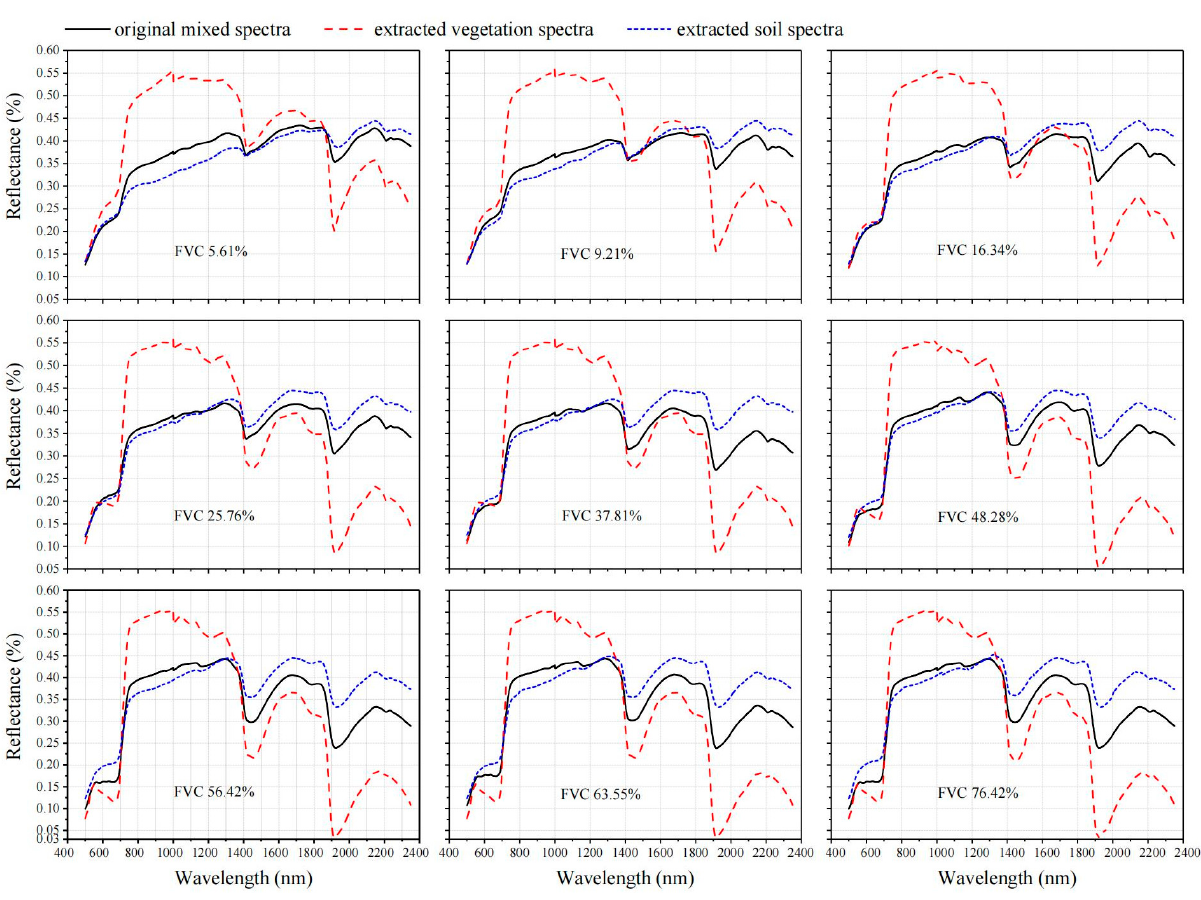
Figure 6. NMF-extracted spectra with different FVCs. Table 2. Estimation accuracy of soil salt content by NMF-extracted spectra at different FVCs. FVC